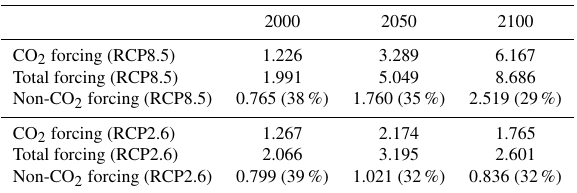
Table 2. Radiative-forcing values (Wm − 2 ) for RCP8.5 and RCP2.6 in 2000, 2050, and 2100. CO 2 forcing and total forcing were calcu- lated using the simple climate model Hector (Hartin et al., 2015). Non-CO 2 forcing is calculated as the difference between total and CO 2 forcing. Percentages in parentheses indicate the percentage of the total